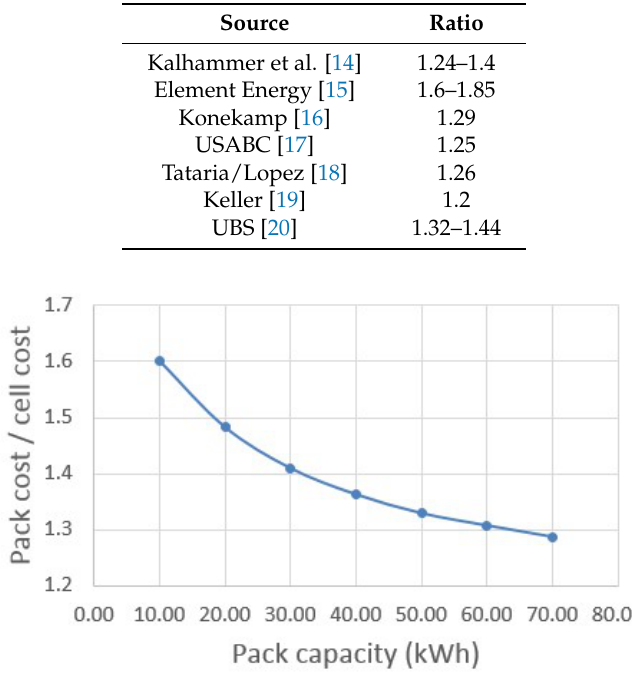
Table 4. Ratios of total pack cost to cell cost suggested by information in published sources.